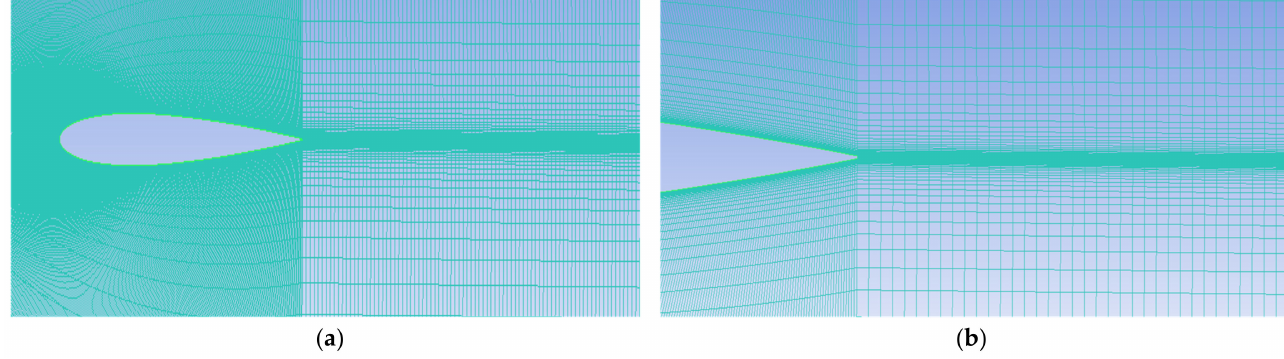
Figure 4. ( a ) Close view of meshes near the WALL region; ( b ) Close view of meshes near the blunt trailing